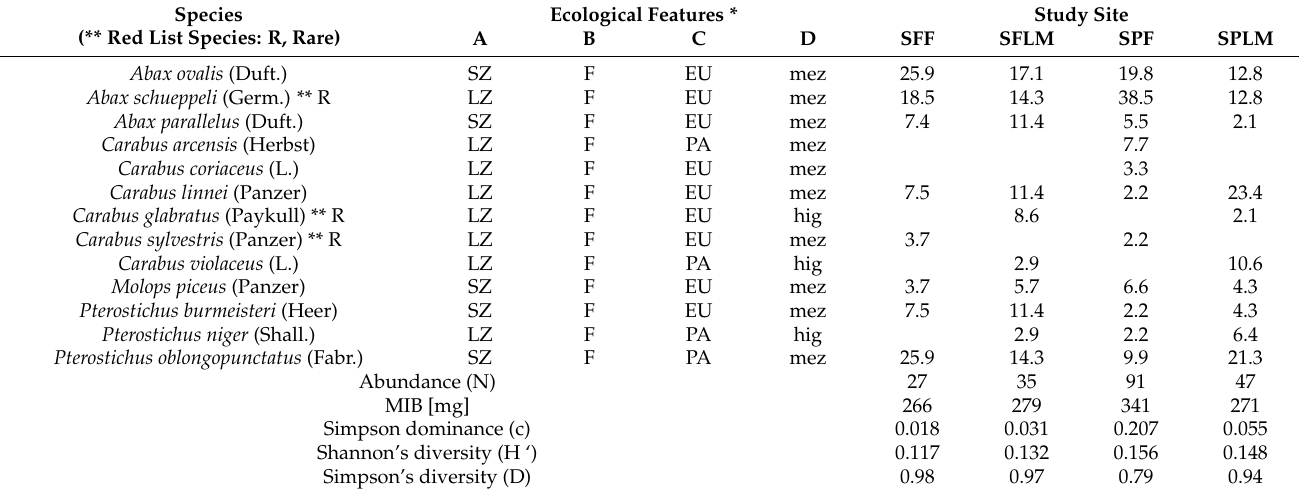
* A—trophic group (large zoophages—LZ, small zoophages—SZ); B—ecological group (forest species—F); C—geographical group (Palaearctic—PA species, European—EU); D—humidity preferences (hygrophilous species—hig, mesophilous species—mez); ** Red-listed species were classified according to the 2002 Red List of Threatened and Endangered Animals in Poland